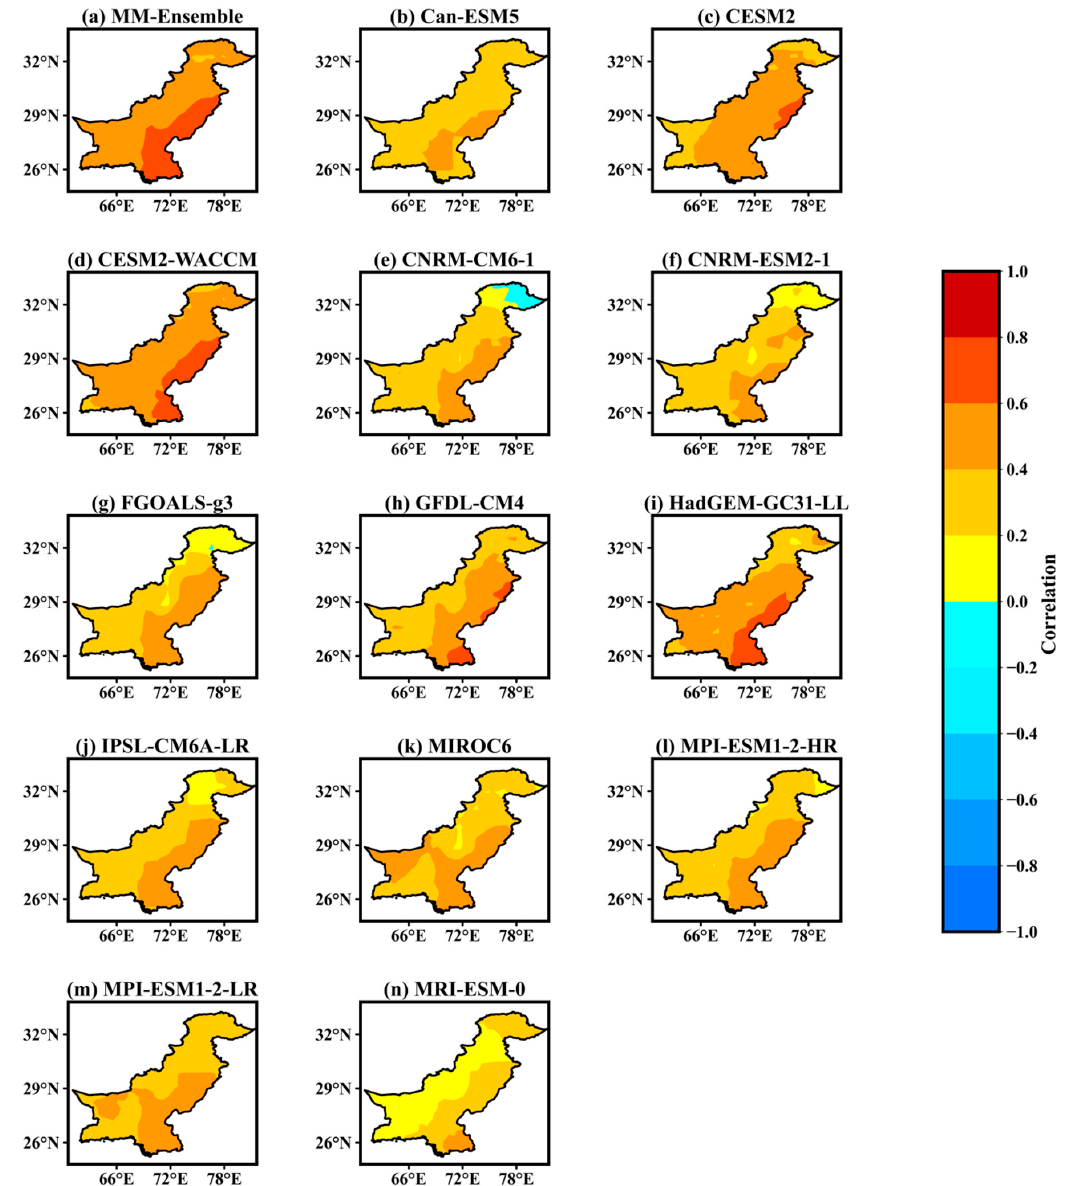
Figure 15. Same as Figure 12 but for winter (DJF) season correlation.